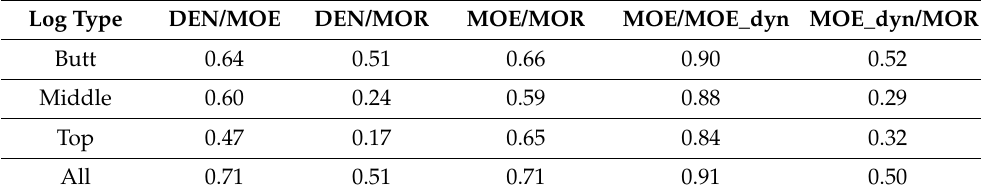
Table 3. Determination coefficients between the individual physical and mechanical